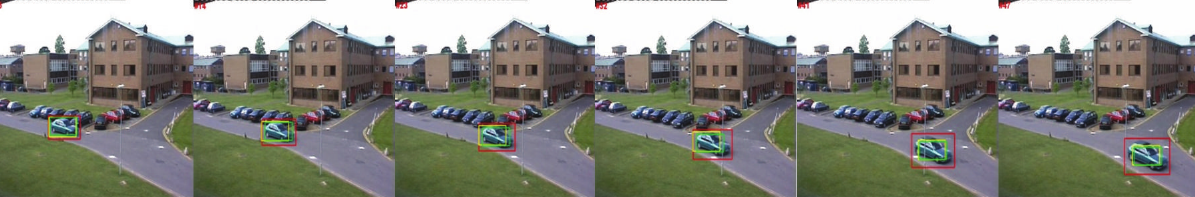
Figure 3: Tracking results of PETS2000 sequence of blue car . Frames 5, 14, 23, 32, 41, and 47 are displayed.